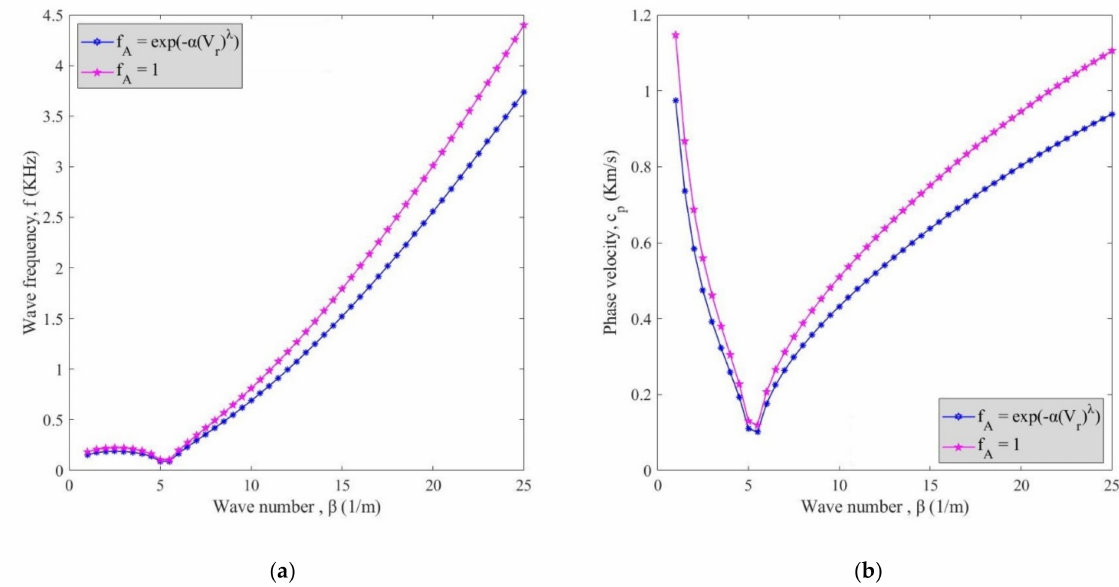
Figure 6. The effect of agglomeration factor on changes of ( a ) wave frequency and ( b ) phase velocity against wave